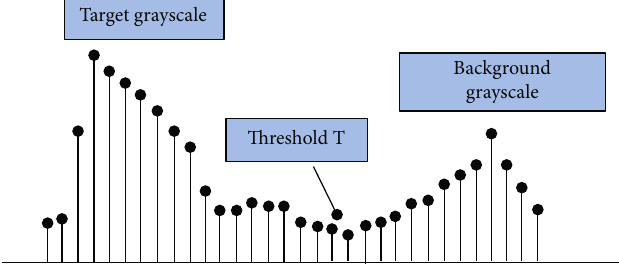
Figure 1: Image grayscale histogram.